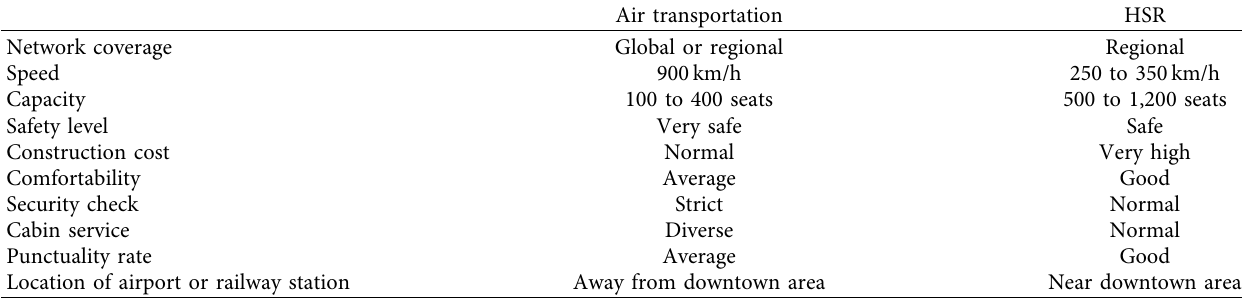
Table 1: Comparation of air transportation and